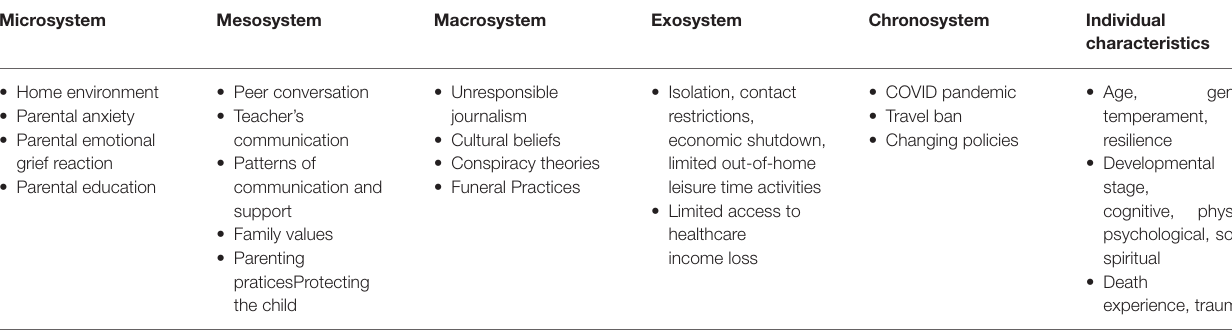
TABLE 1 | Factors affecting the process of death and grief among children in the COVID in each system of Bronfenbrenner’s bio-ecological model.